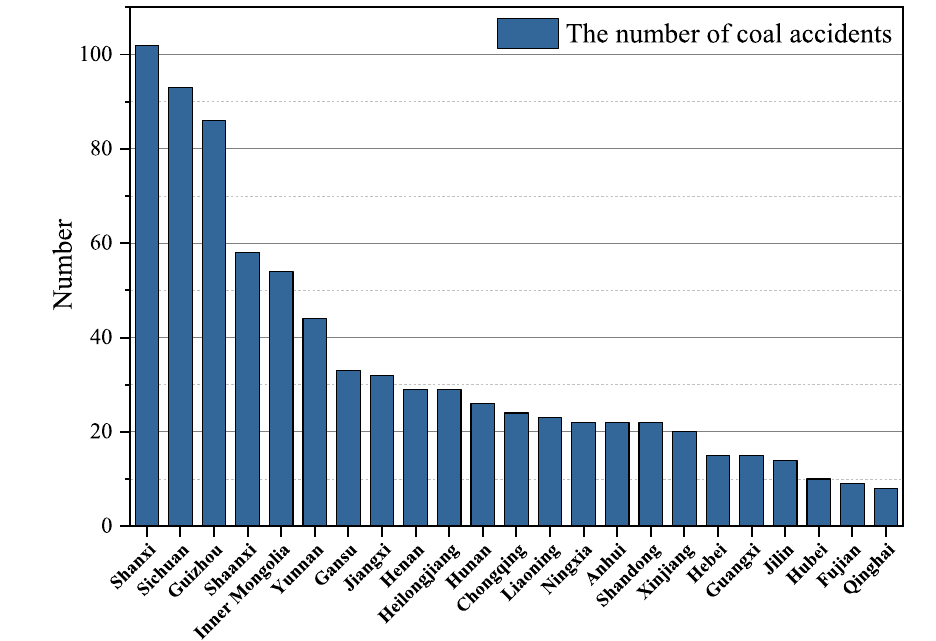
Fig. 8 Distribution of the number of coal mine accidents in China